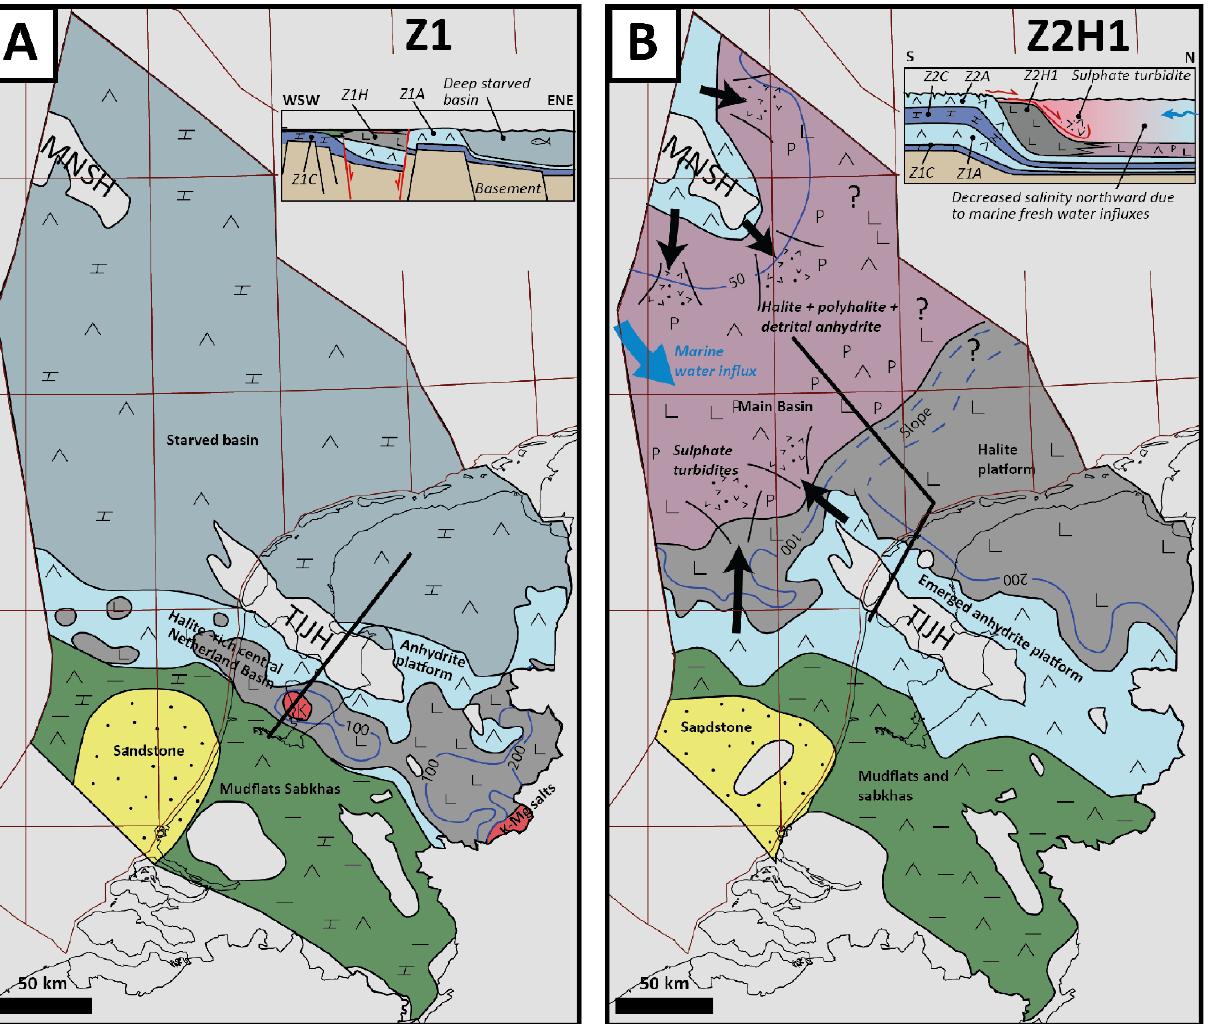
Figure 8. Facies and isopach map of the Z1H ( A ) and Z2H1 ( B ) units (modified after [8]) with conceptual sections illustrating the depositional setting (upper right).